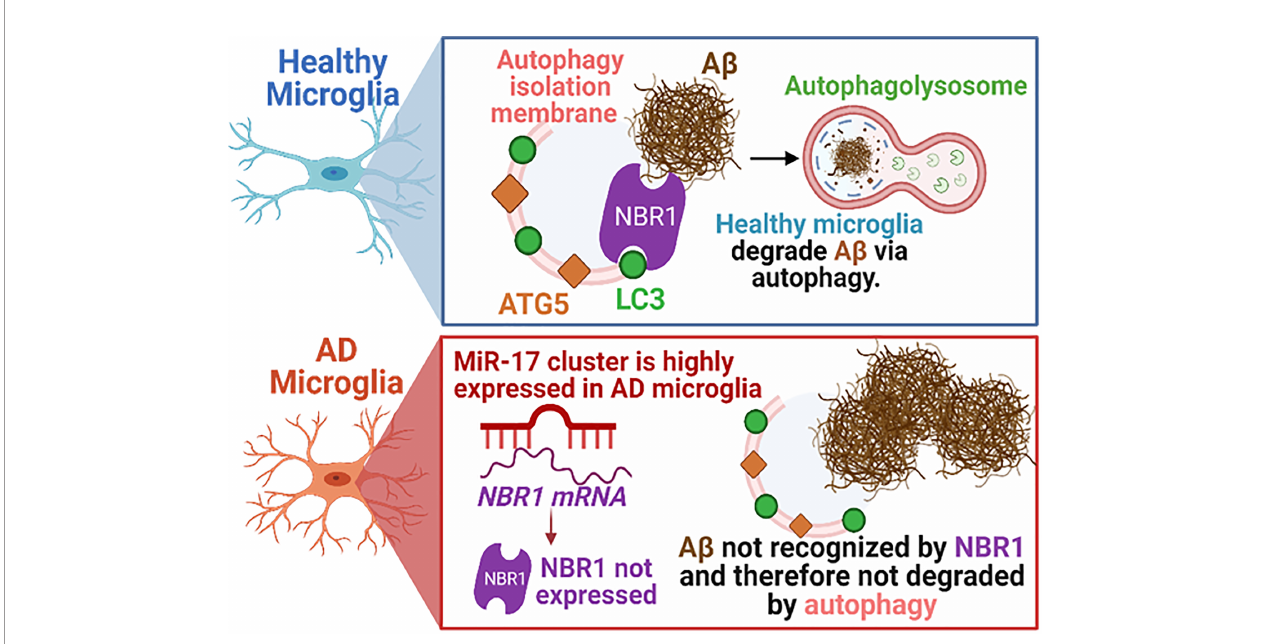
FIGURE 8 | Schematic illustration of the interplay between miR-17 , NBR1, and A b degradation in both healthy and Alzheimer diseased microglia. AD, Alzheimer ’ s disease; ATG5, Autophagy Protein 5; NBR1, Neighbor of BRCA1 gene 1 Protein; LC3, Microtubule Associated Protein 1 Light Chain 3; A b , Amyloid beta; miR-17, microRNA-17. Synopsis: Autophagic clearance of A b is disrupted in primary AD mouse microglia (5xFAD). NBR1 is required for A b degradation and is downregulated in microglia in human AD in regions with high A b burden. The expression of the Mirc1/Mir17-92 microRNA cluster is elevated in AD, including in microglia adjacent to A b plaques in human AD and in 5xFAD microglia. Elevated expression of miR-17 correlates with reduced expression of its predicted target, autophagy receptor NBR1. Inhibiting miR-17 in primary AD mouse microglia is suf fi cient to restore A b degradation, autophagy, and NBR1 puncta formation in AD microglia in vitro and NBR1 expression in vivo